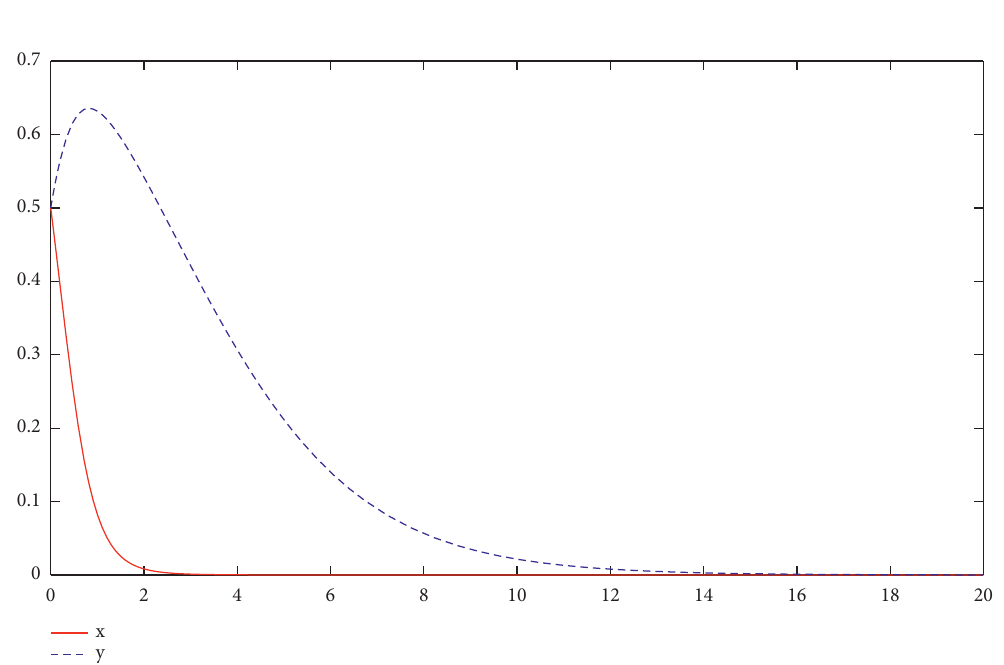
Figure 3: The evolution track of scenario